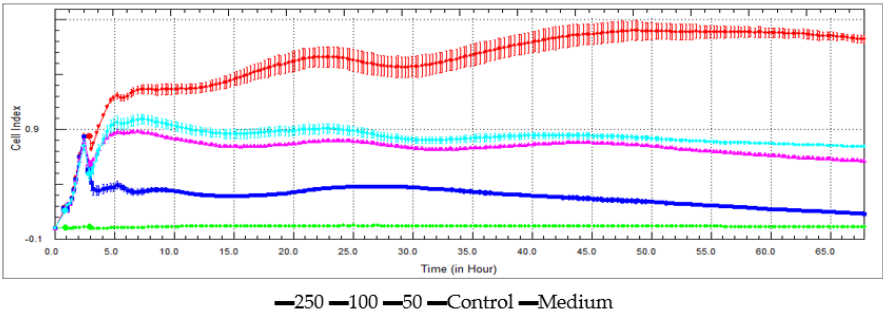
Figure 7. Antiproliferative activity against the Hela cell lines of ethyl acetate extract.